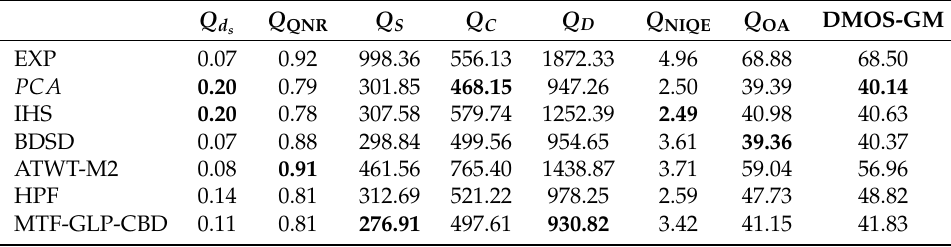
Table 12. IKONOS Roma River scene, full-resolution, image quality assessment metrics, and DMOS GM quantitative results. The bold number indicates the best performing PS method according to each quality